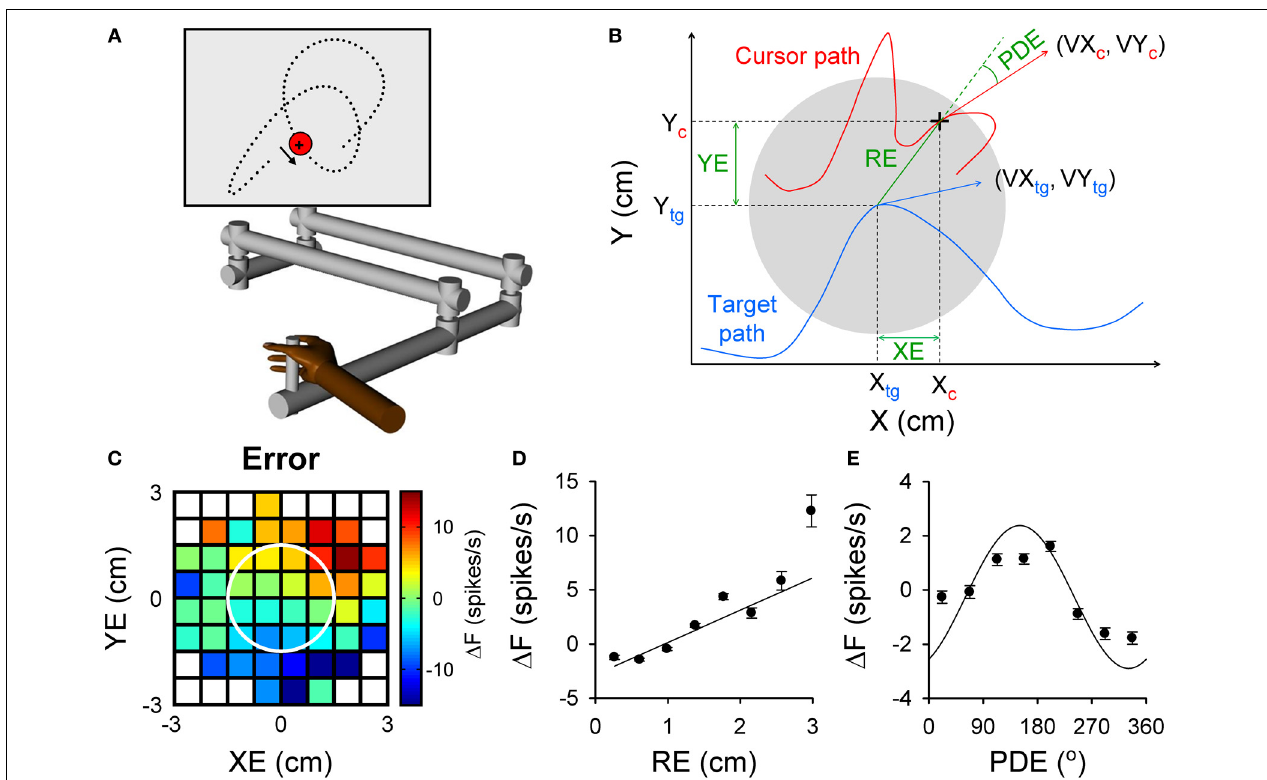
FIGURE 1 | Purkinje cell simple spike modulation in relation to task errors and hand kinematics during random tracking. (A) Using a robot manipulandum, moving in an horizontal plane, monkeys track a randomly moving target on a vertical screen, by keeping the cross-shaped cursor within thetarget(3cmindiameter).Excursionsofthecursoroutsidetargetarealonger than 500ms result in trial abort. (B) Geometry of the motor parameters. Target (gray circle) moves on a random trajectory (blue trace). Cursor (black cross) maps the hand movement (red trace). Hand kinematic parameters are position (X c and Y c ), velocity (VX c and VY c ) and speed (magnitude of the hand velocity